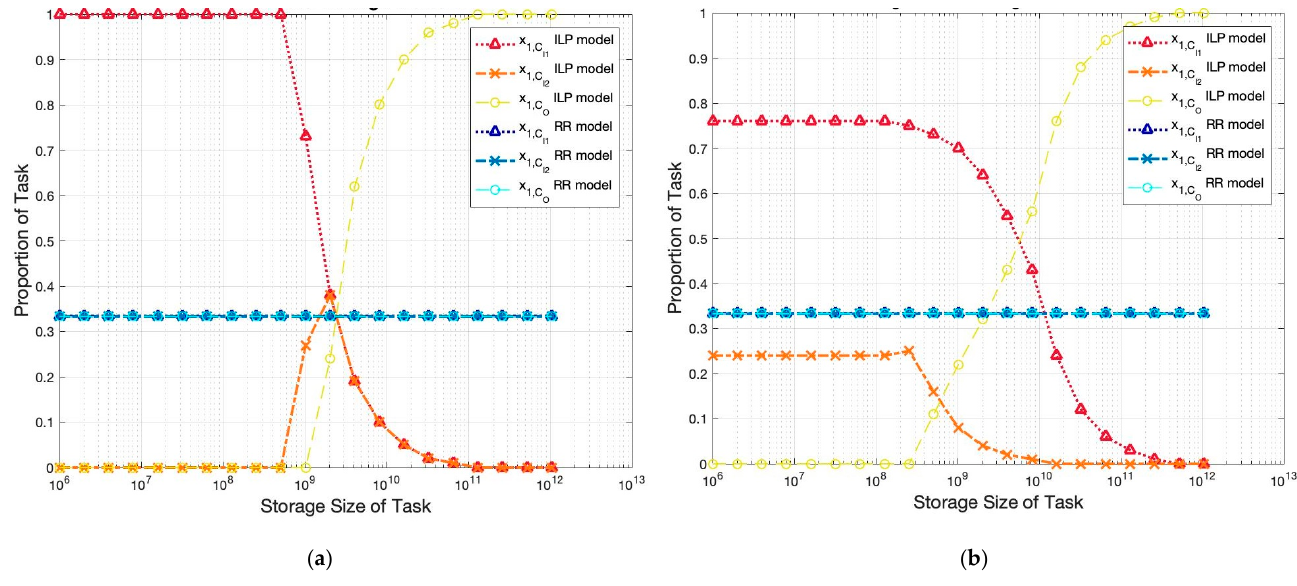
Figure 3. Proportion of task in case study 1: ( a ) peer-to-peer federated cluster scenario; ( b ) edge-core cluster scenario.